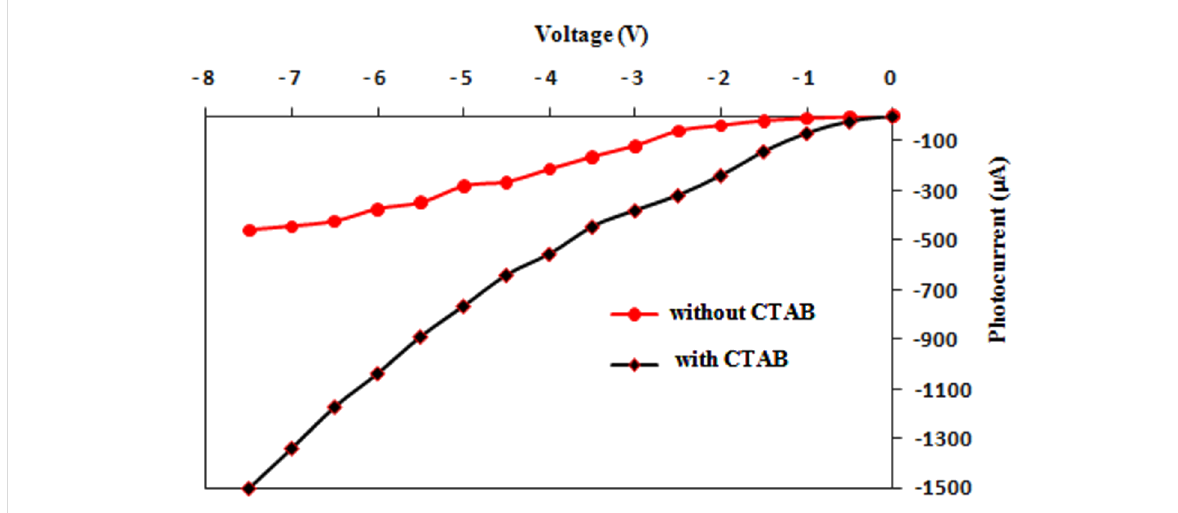
Figure 12: Effect of CTAB on the I – V characteristics under illumination of the heterojunctions.